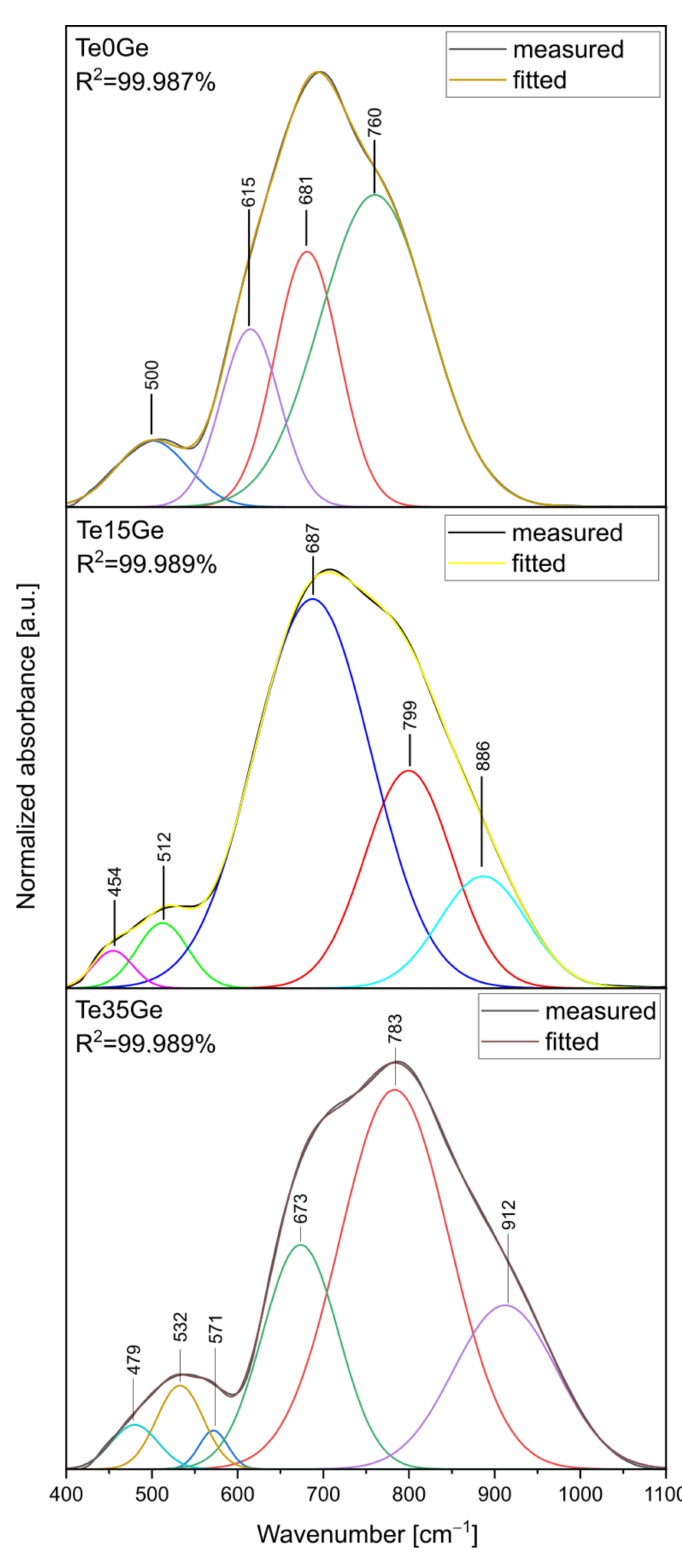
Figure 5. MIR spectra decomposition of the Te0Ge, Te15Ge, and Te35Ge glasses doped with Eu 3+